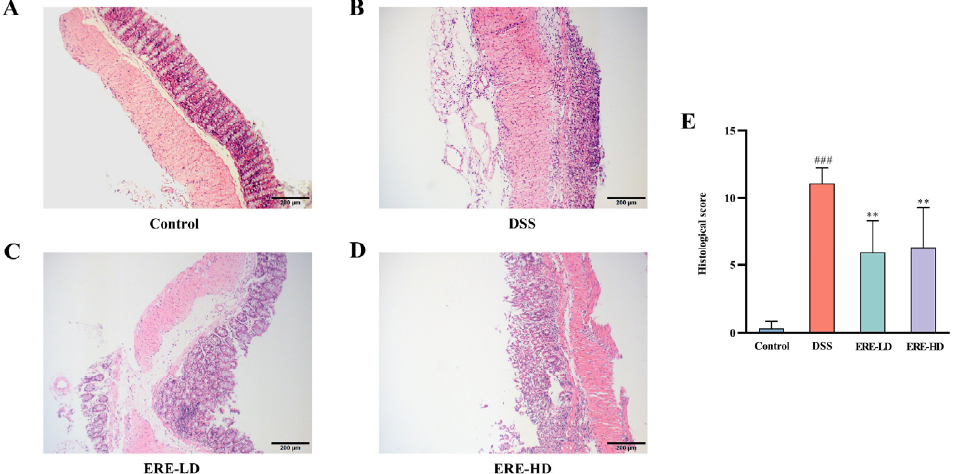
Figure 7. Effects of ERE on the histopathological changes in the colon tissues. Representative H&E staining sections of colon tissues ( A – D ). Scale bar = 200 µ m. ( E ) Histopathology scores of colon tissues in different groups. The values are expressed as the mean ± S.D.: ** p < 0.01 compared with DSS group; ### p < 0.001 compared with control